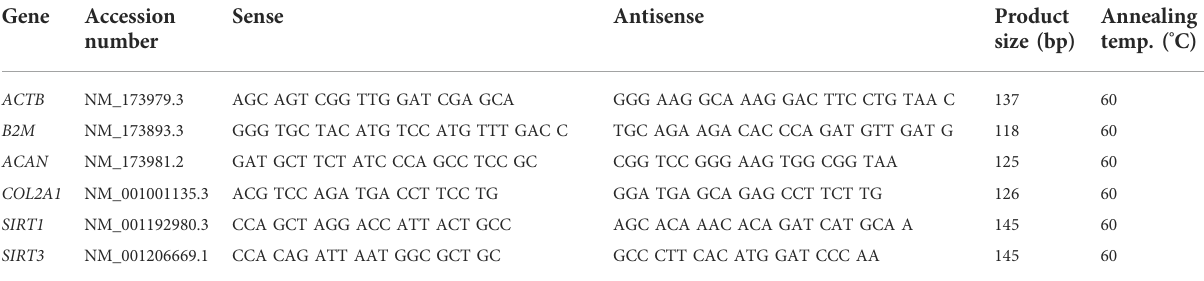
TABLE 1 Primer sequences used for quantitative gene expression